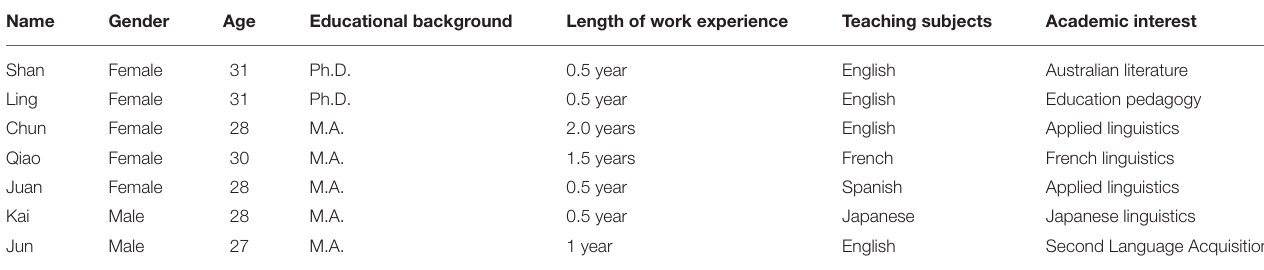
TABLE 1 | Participating teachers’